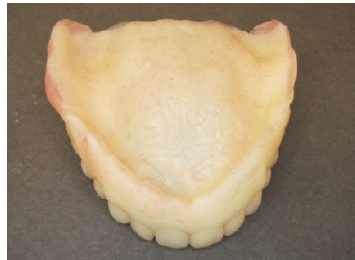
Figure 13. Corrective functional impression with the trial denture.